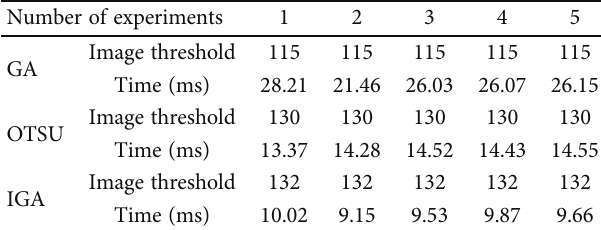
Table 1: Thresholds and time-consuming conditions of the three segmentation methods.